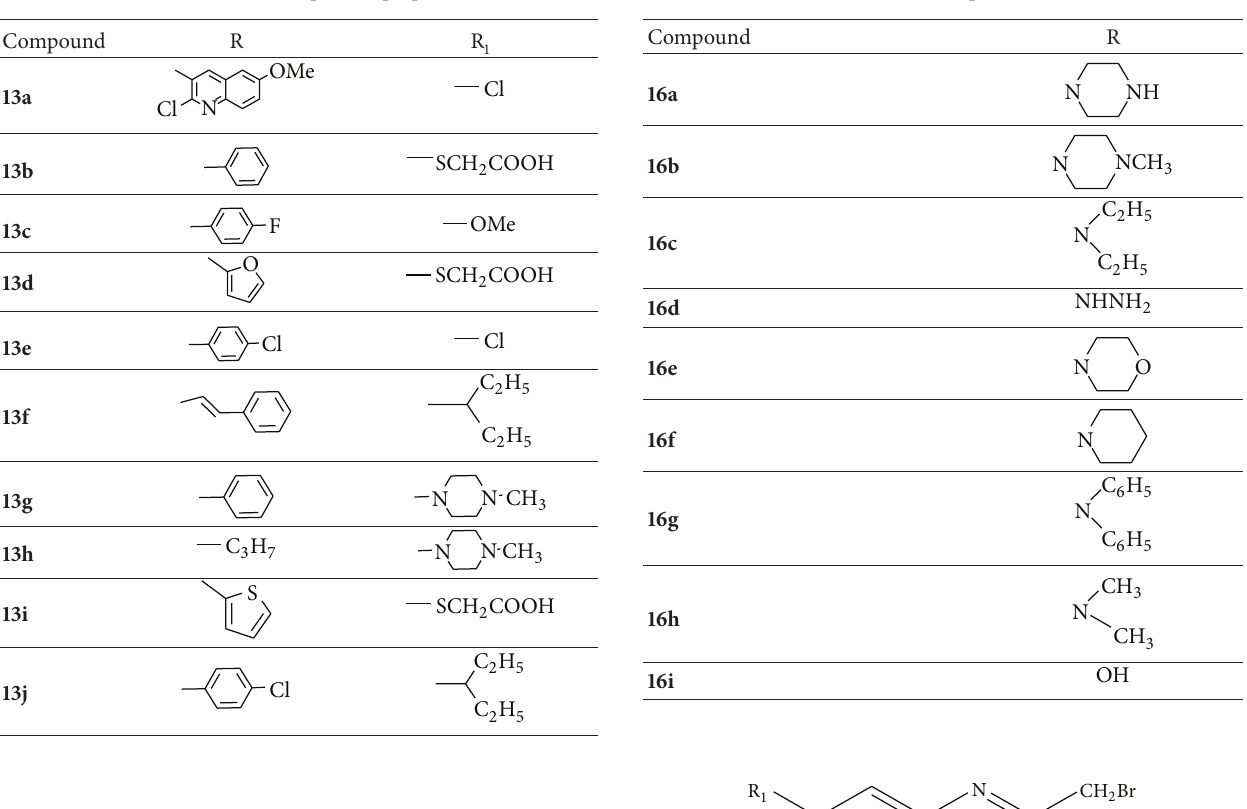
Table 4: List of compounds prepared.